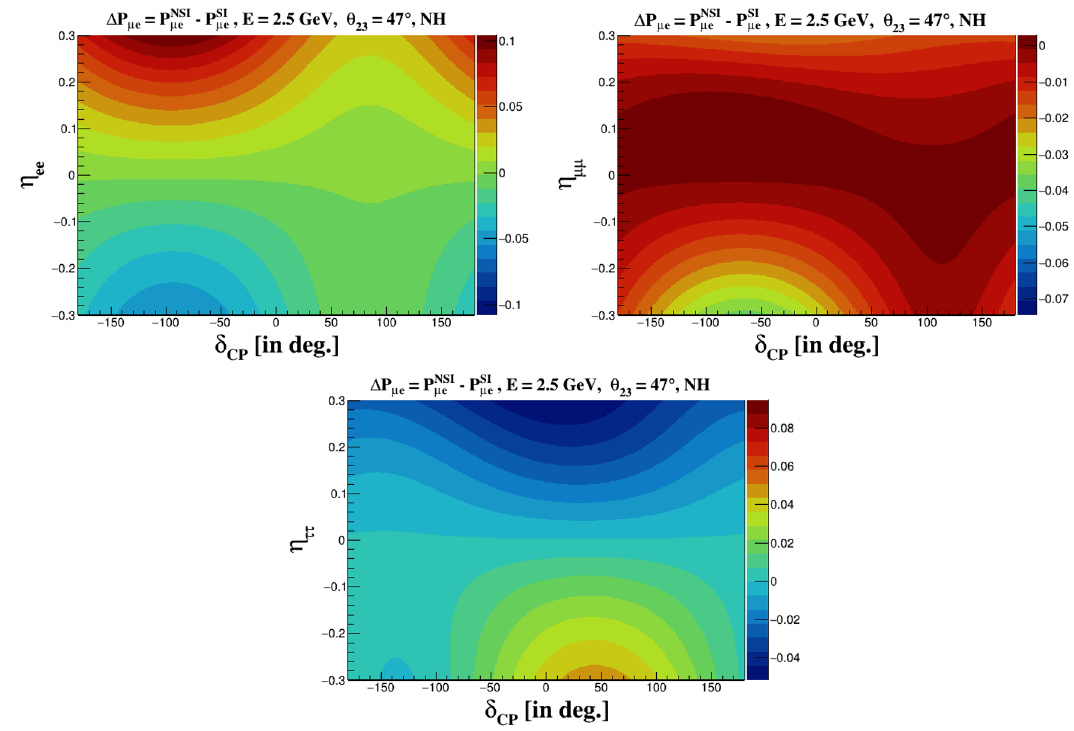
Figure 3 . The variation of ∆ P αβ on η αβ – δ CP plane. We show the results for η ee (top-left panel), η µµ (top-right panel) and η ττ (bottom